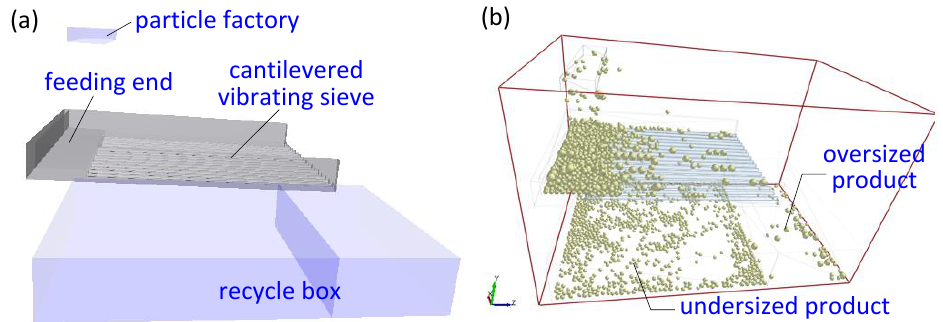
Figure 5. Discrete element method (DEM) model of a cantilevered vibrating sieve (CVS) without particles ( a ) and with particles ( b ).